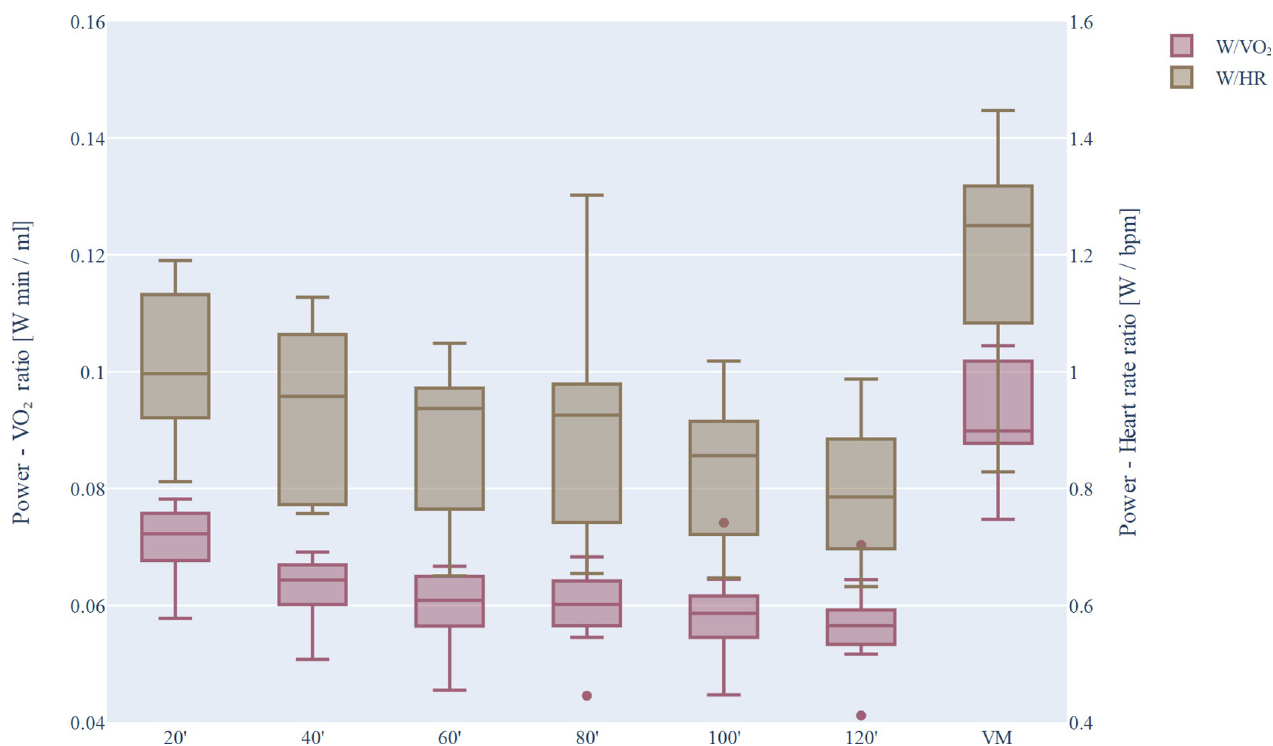
Fig 3. Power/VO 2 and power/heart rate ratios as a function of time during the long dehydration protocol. 20’, 40’, ... , 120’: averages of VO 2 and heart rate parameters measured over 20-minute workout periods, respectively. VM: sampling time at the maximum power after 120 min preload. The median, q1 and q3 quartiles, as well as the minimum and maximum values, are represented on the box